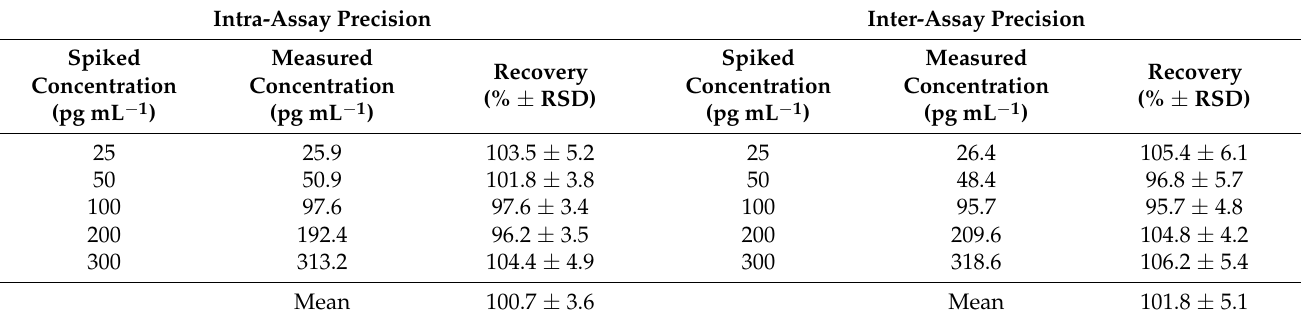
Table 5. Precision and accuracy of the proposed CLEIA for